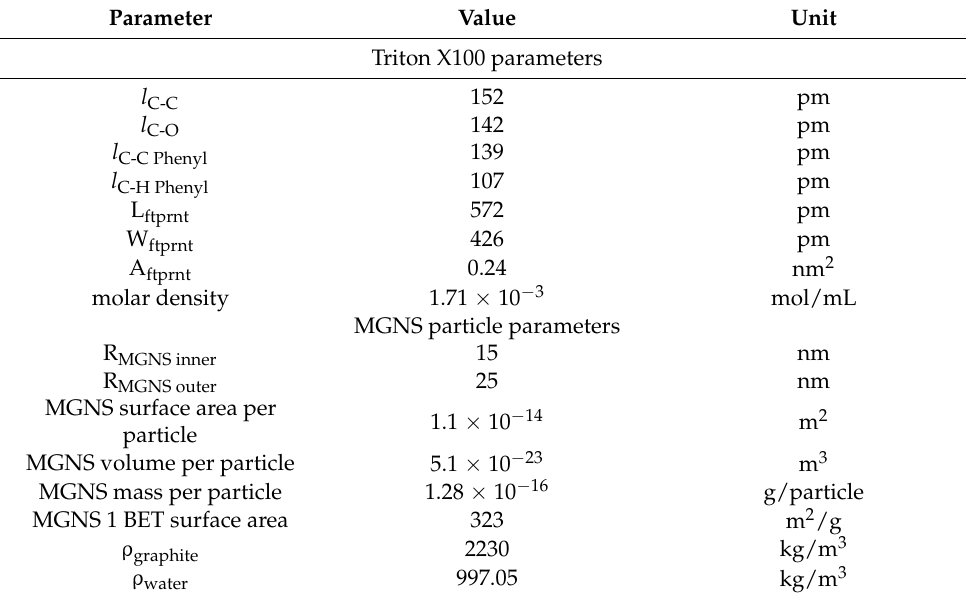
Table 1. Summary of geometric adsorption model